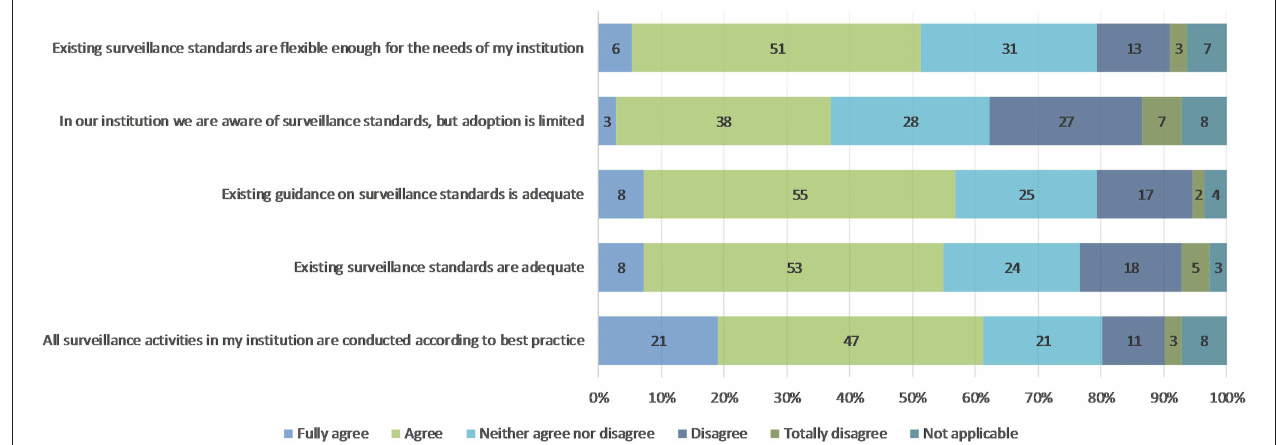
FIGURE 2 | Respondents’ answers to statements on quality and adoption of surveillance standards, n = 111.